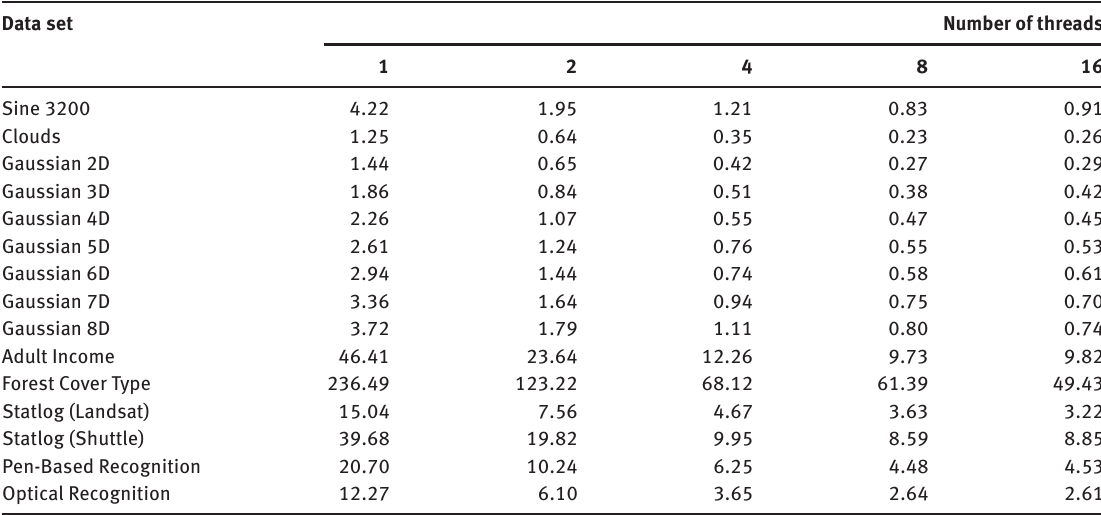
Table 3: Execution Time, in Milliseconds, of the Serial and the Parallel AMCOV Generation Algorithms. Data